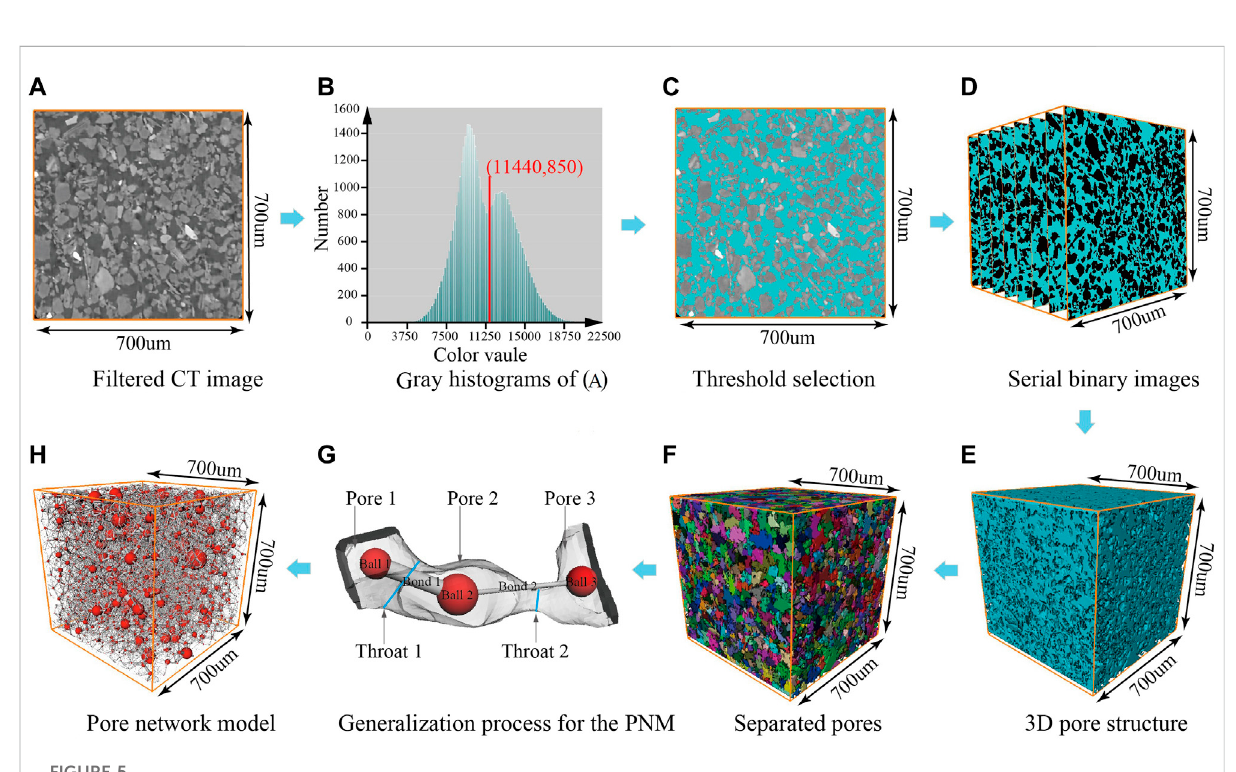
Reconstruction of the 3D PNM for pores in loess